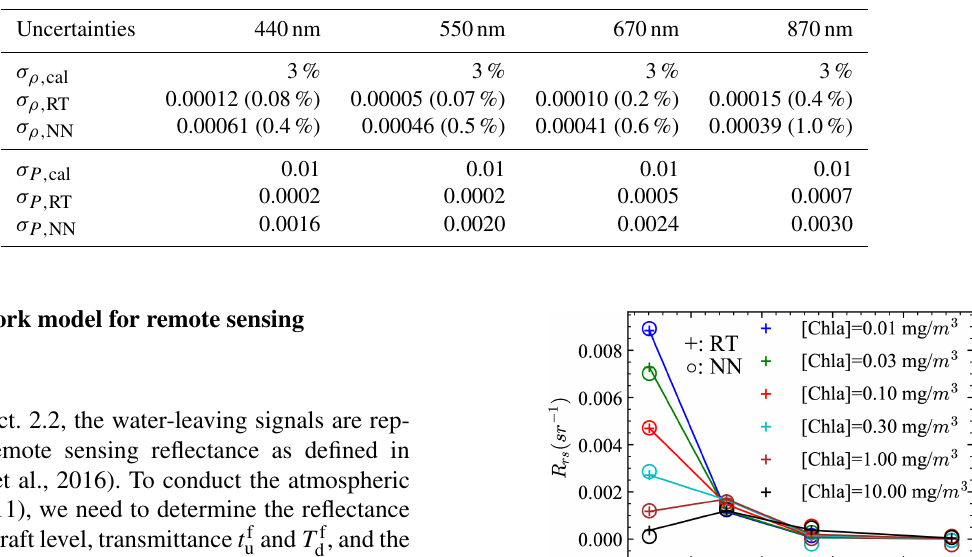
Table 4. Comparisons of the uncertainties for reflectance ( ρ ) and DoLP ( P ) for both measurement and forward model including calibration uncertainty ( σ cal ), the radiative transfer simulation uncertainty ( σ RT ), and the NN uncertainty ( σ NN ). The same σ ρ, NN and σ P, NN have been shown in Table 3 and are repeated here for comparisons. (As in Table 3, the percentage values listed in the table indicate the percentage uncertainties.)